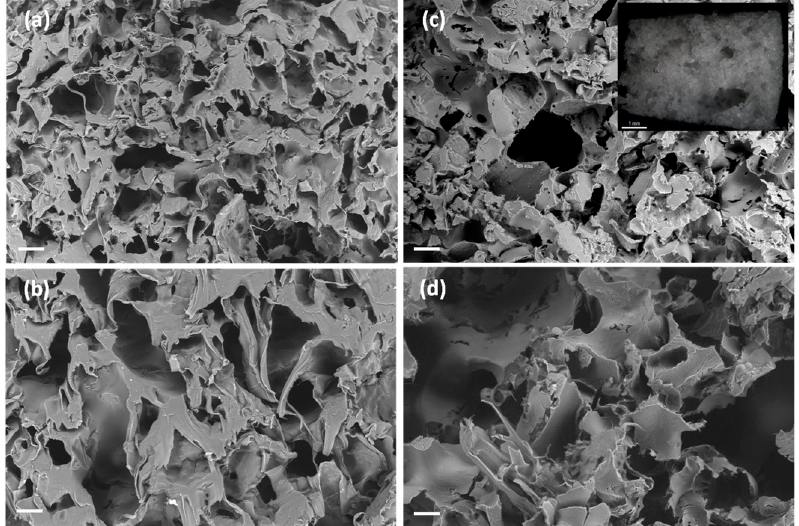
Figure 3. SEM-images of cross sections of ( a,b ) PCL(0K)75BA and ( c,d ) PCL(5K)75BA polymeric scaffolds loaded without and with 5 wt.% of ketoprofen, respectively. Insets in ( a , c ): Optical micrographs of the scaffolds. Scale bars ( a , c ): 200 µm; ( b , d ) 100 µm; 1 mm (inset).